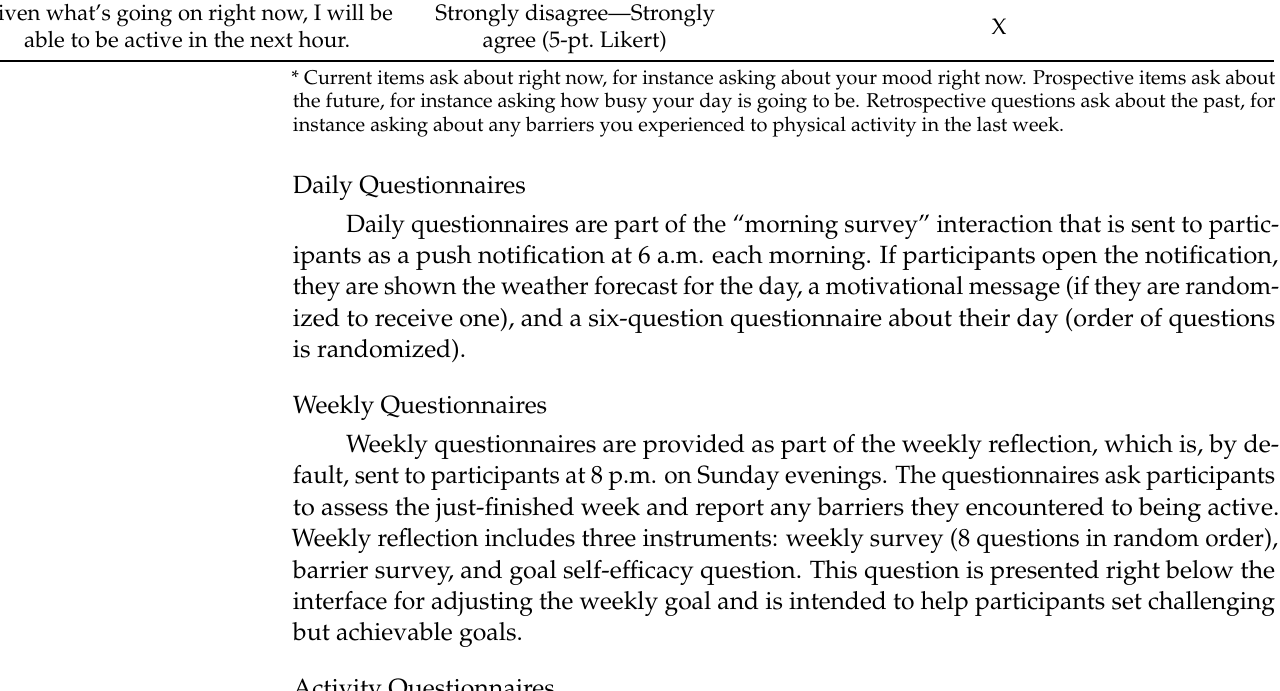
Table 2. Cont. EMA Bursts—once every three months for seven days How committed do you feel right now to Not at all—Very (5-pt. Likert) X being physically active today? Given what’s going on right now, I will be able to be active in the next